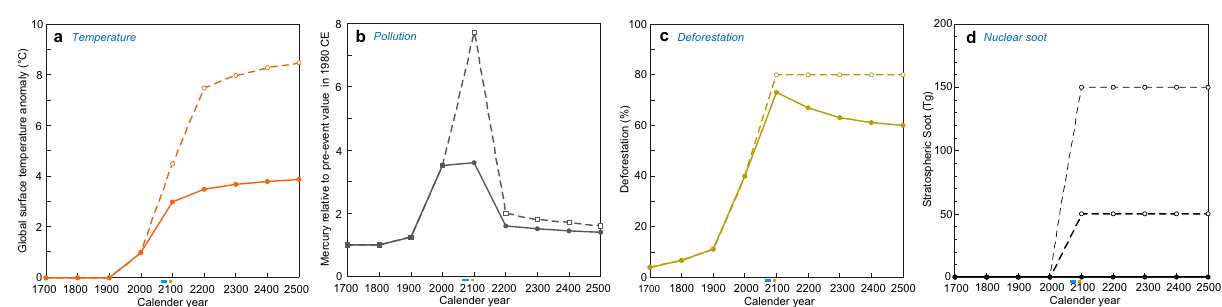
Figure 2. Changes in global surface temperature anomalies ( a ) 8,9 , mercury concentrations (relative to pre- event values) as a proxy for pollution (see Methods and Supplementary Table S2 for future mercury rate) ( b ) 11,25,26 , deforestation areas % (see Methods and Supplementary Table S2 for future deforestation) ( c ) 12,28 , and stratospheric soot amounts introduced by nuclear war inducing sunlight reduction and global cooling ( d ) 15 from CE 1700 to 2500. Solid line in ( a – c ): the most likely case. Dushed line in ( a – c ): the worst case (see “Methods”). ( d ) shows stratospheric soot amount by two nuclear war scenarios after Coupe et al. 15 and no nuclear war case. The light blue and orange bars under the horizontal axes show the timing of the stoppage of GHG emissions in the most likely case and in the worst case, respectively. These data are shown in Supplementary Table